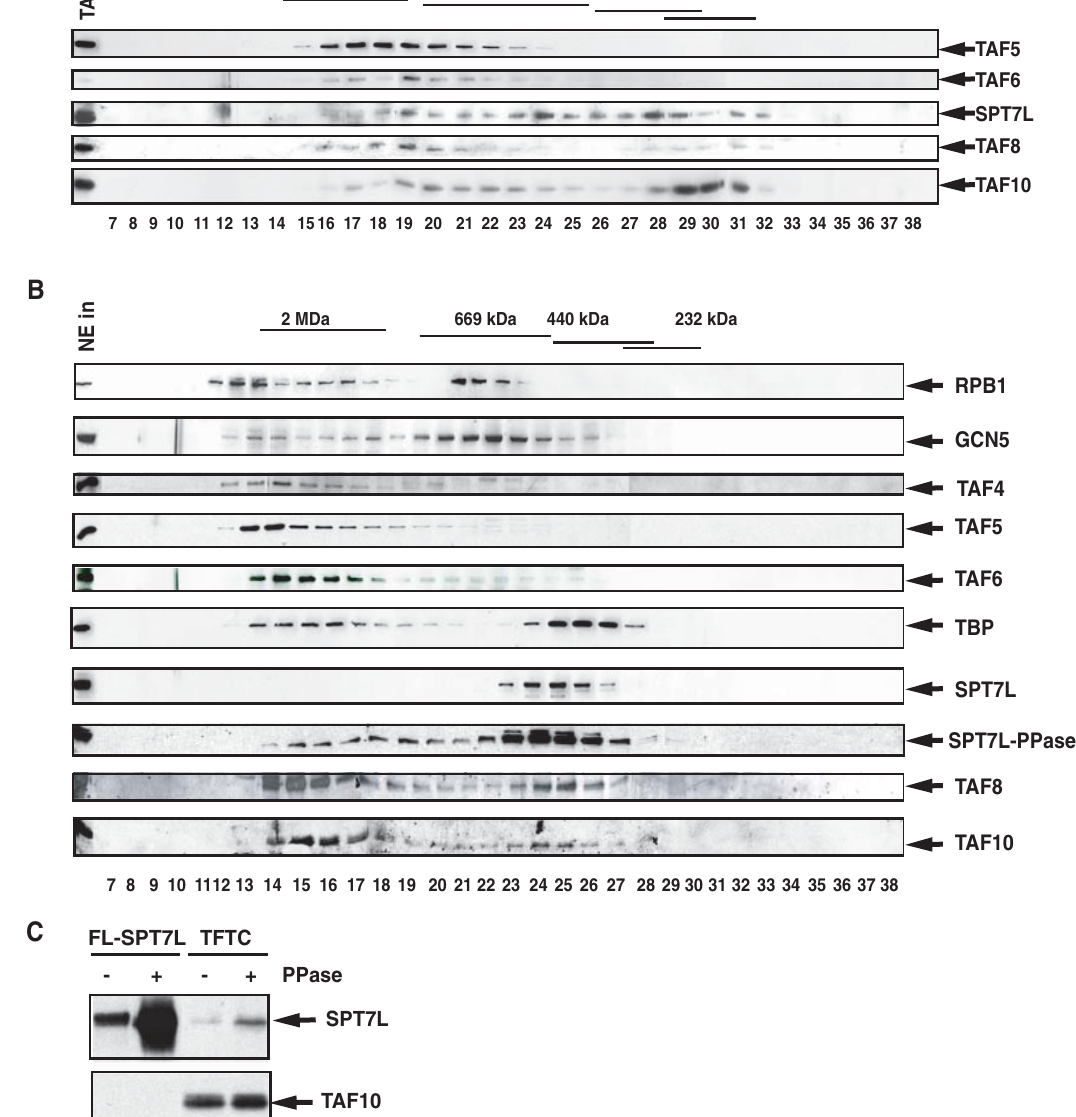
Figure 6. The TAF8-, TAF10- and SPT7L-containing complex has a size of about 300–350 kDa and may exist invivoin crude nuclear extracts. Immunupurified and eluted TAF10-containing complexes (TAF10 IP) (A) , or HeLa nuclear extract (NE) (B) (50 m l) were injected on a Superose 6 size exclusion chromatography column using the SMART FPLC system (Pharmacia) and separated. Portions of the input (in; 5 m l) and every fraction from 7 to 38 (20 m l) were analysed by western blot (as indicated). Fraction numbers are shown under each lane and the elution profile of known molecular mass markers is indicated above the panels. To detect the non-phosphorylated form of SPT7L, 20 m l from each fraction was first phosphatase treated for 30 min at 37 u C, then separated by SDS-PAGE and analyzed by western blot with the anti-SPT7L mAb (panel SPT7L-PPase). (C) Baculovirus expressed SPT7L in WCE (lane 2) and purified TFTC (lane 4) were treated with phosphatase (PPase) for 30 min at 37 u C, separated on SDS-PAGE and analysed by western blot with the anti-SPT7L mAb (15) (upper panel), and an anti-TAF10 mAb (lower panel). The corresponding mock treated fractions are shown in lanes 1 and 3, respectively. doi:10.1371/journal.pone.0000316.g006 (Fig. 6A). The broad elution profile of TAF10 suggests that this protein as well as proteins associated with it is present in several different complexes in human HeLa cells.